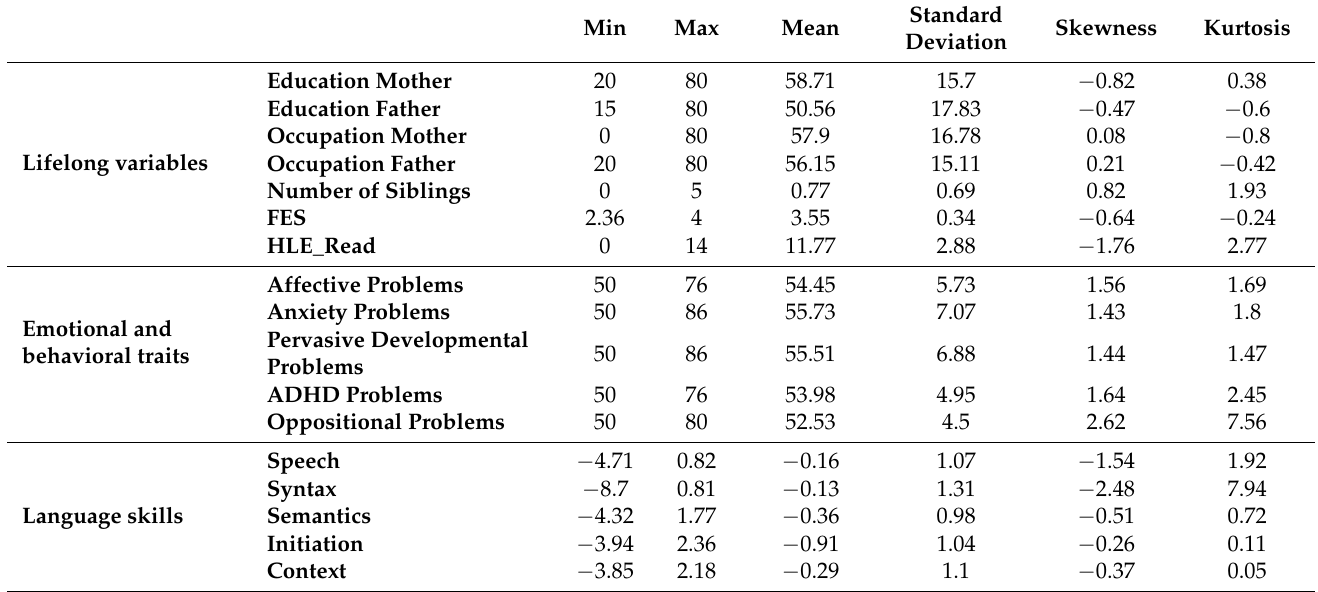
Table 1. Descriptive statistics of lifelong variables, emotional and behavioral traits, and language skills in the total sample ( n = 677).